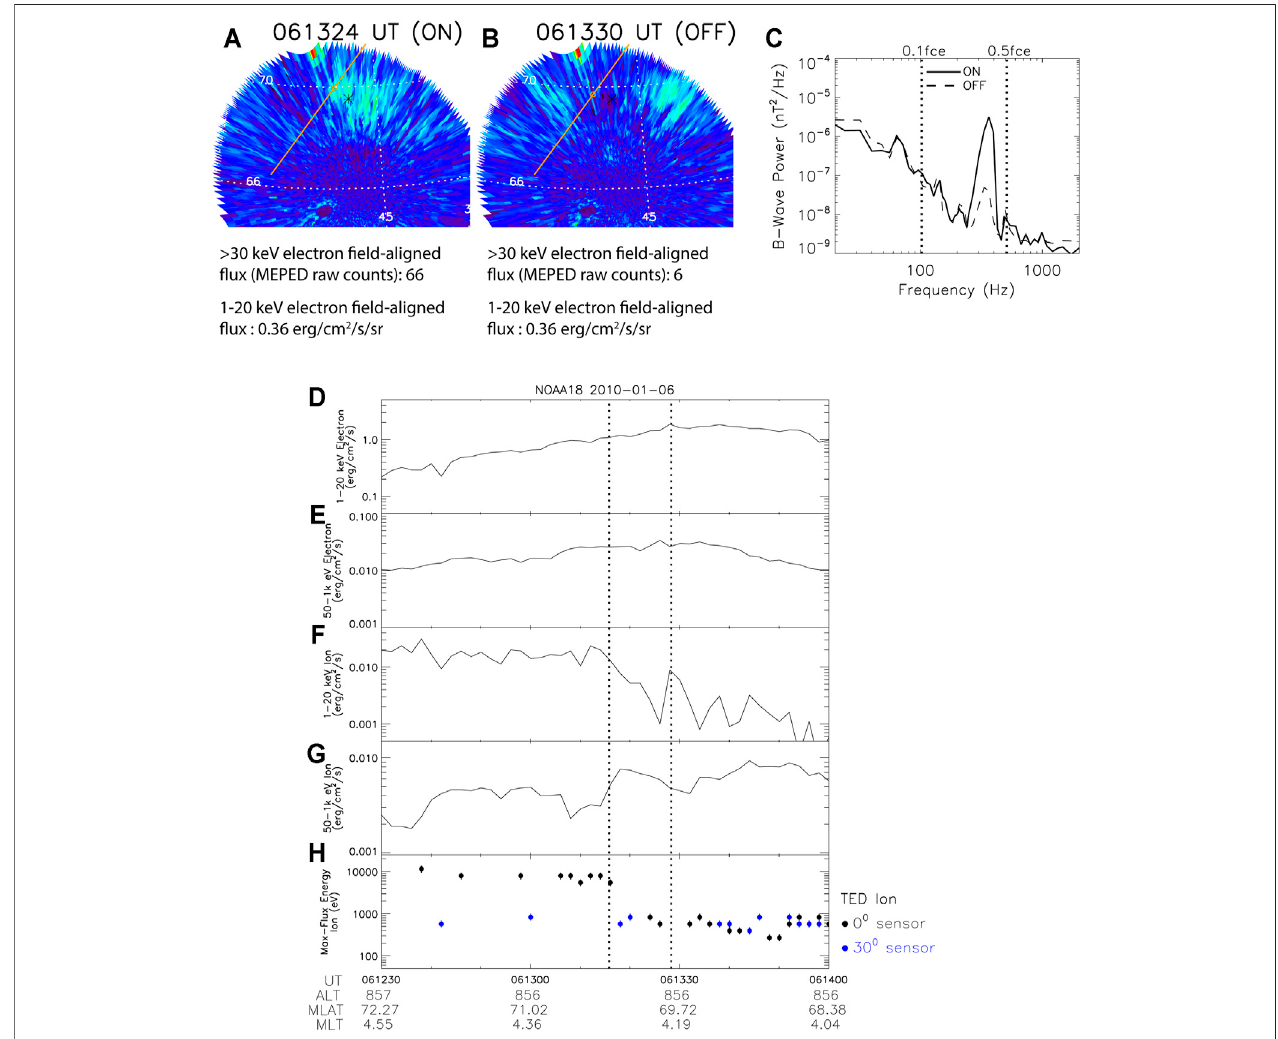
FIGURE 4 | (A,B) show the on-off variation of the PPA during the NOAA18 passage. The trajectory of NOAA18 is plotted as an orange line, and an open circle indicates the NOAA18 footprint at the current ASI frame epoch. THEMIS-E footprint is shown as asterisk. (C) THEMIS-E magnetic fi eld wave spectra sampled at the same time epochs as in (A,B) . (D – H) show NOAA18 observations. (D) Electron precipitation fl uxes in 1 – 20 keV energy range; (E) Electron precipitation fl uxes in 50 – 1,000 eV energy range; (F) Ion precipitation fl uxes in 1 – 20 keV energy range; (G) Ion precipitation fl uxes in 50 – 1,000 eV energy range; (H) Ion max- fl ux energy band. Two vertical dotted lines mark the PPA crossing interval of